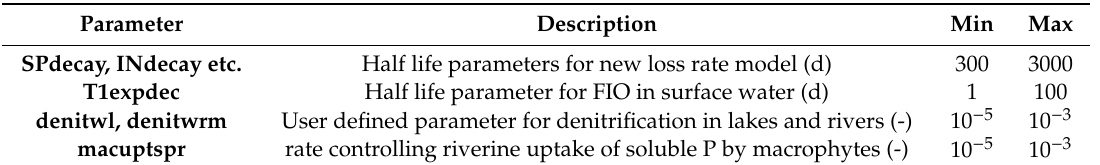
Table 2. Sensitive water quality calibration parameters and ranges. SP = soluble phosphorus, IN = inorganic nitrogen, FIO = faecal indicator organisms.